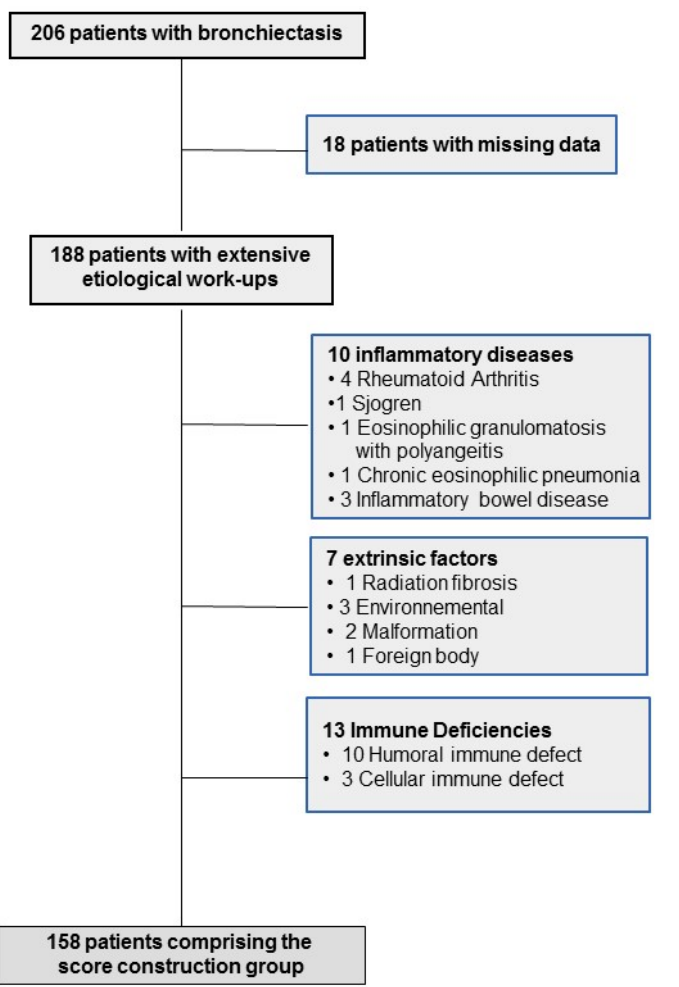
Figure 1. Study flow chart for the construction cohort.